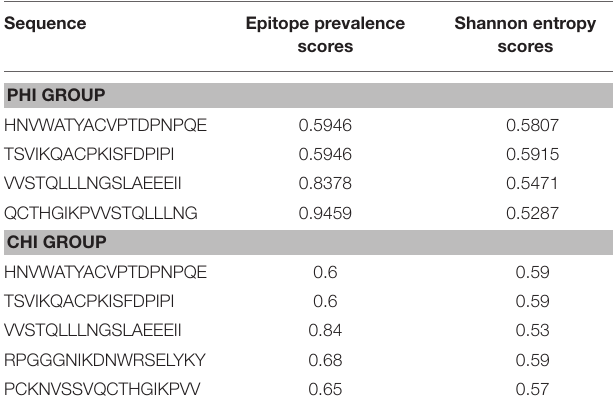
TABLE 4 | Relatively conserved epitopes in PHI and CHI